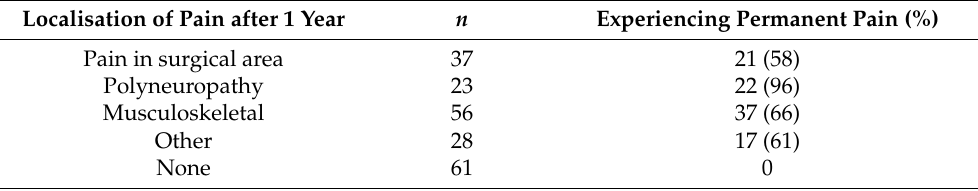
Table 3. Localisation and permanence of pain 1 and 2 years after surgery.